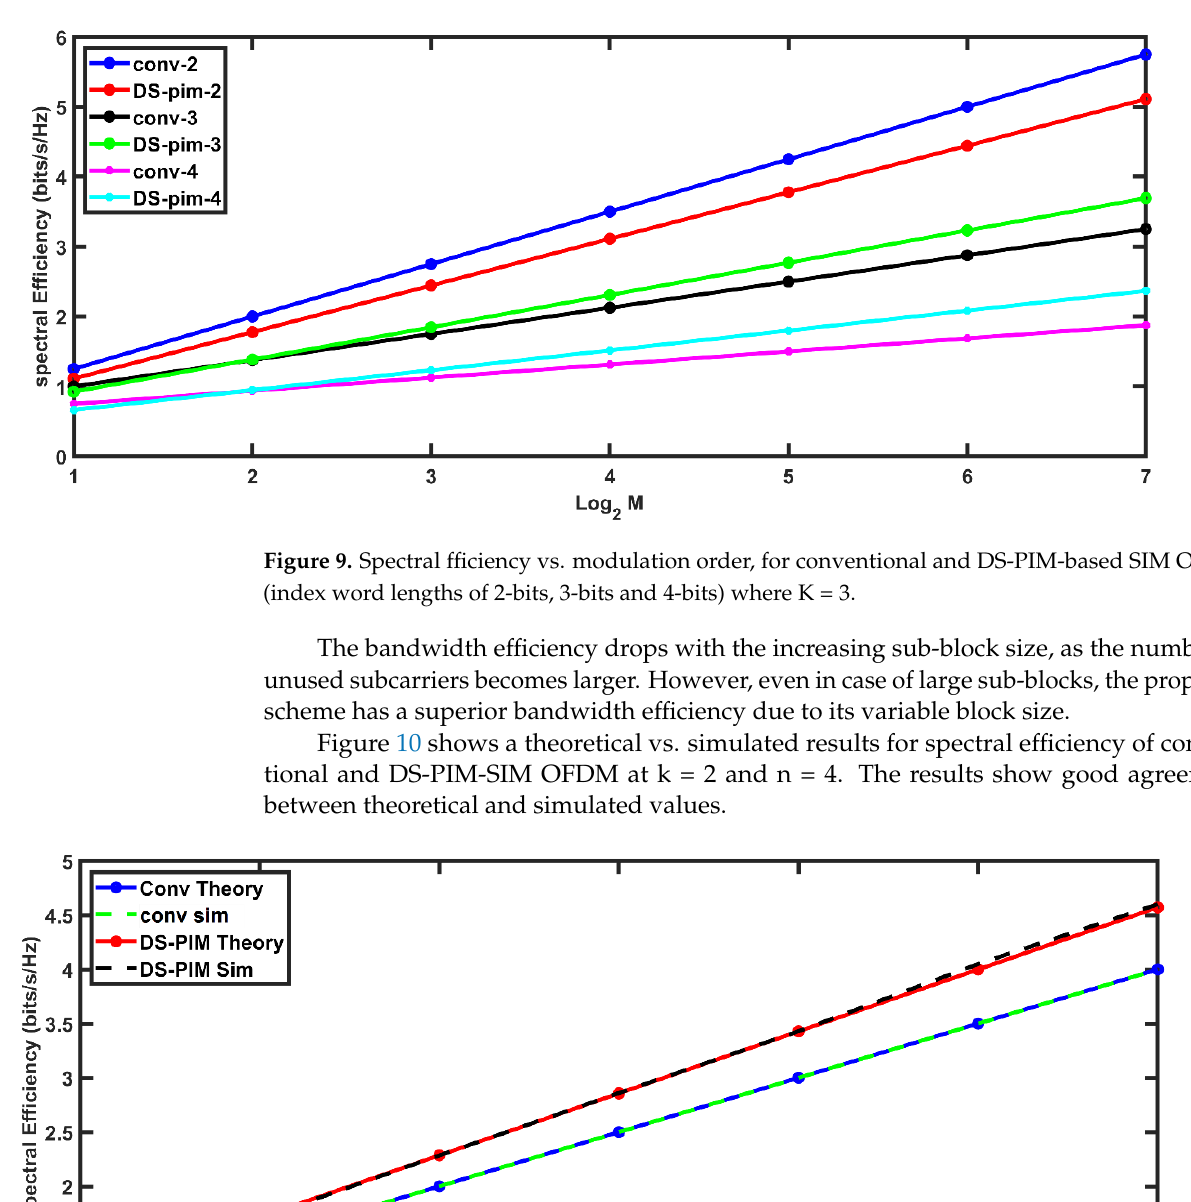
Figure 11. CNR vs. SER of conventional and DS-PIM based SIM OFDM for index word lengths of 2 – bits, 3 – bits and 4 – bits.